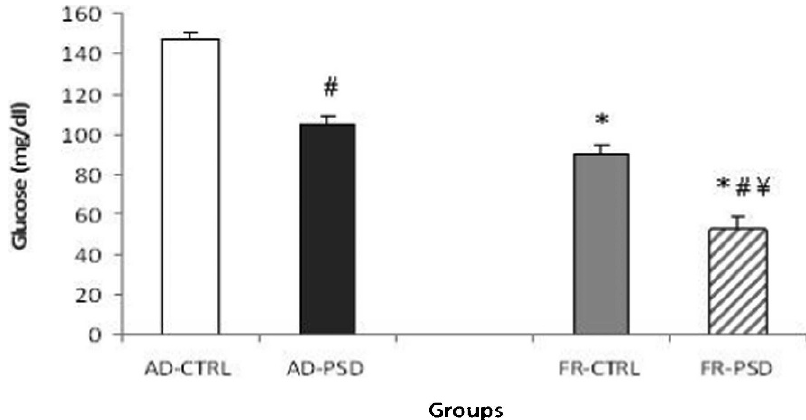
Figure 3 - Effects of food restriction (FR) or ad libitum diet (AD) on glucose concentrations in home-cage control (CTRL) and paradoxical sleep-deprived (PSD) rats. * Significantly different from the AD-CTRL group, ¥ Significantly different from the AD-PSD group and # Significantly different from the respective